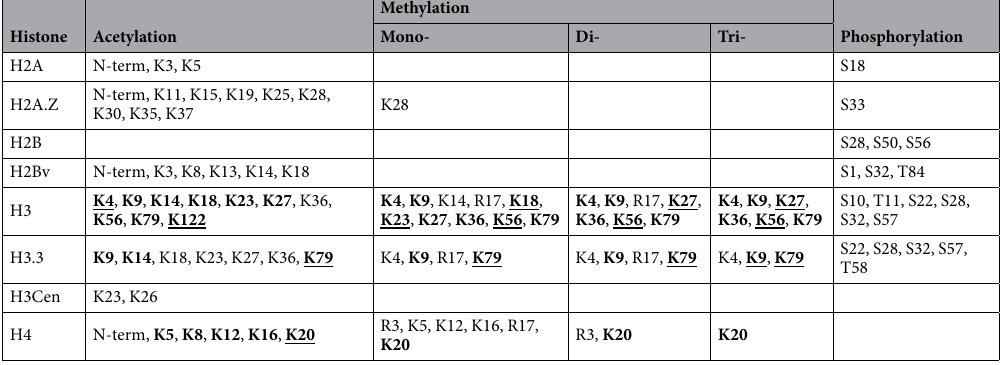
Table 1. Histone PTMs identified in P. falciparum parasites. Regular font indicates qualitative PTMs identified in this study (also previously identified). Bold indicates quantitative PTMs identified in this study (also previously identified). Bold & underlined indicates quantitative PTMs identified in this study (novel